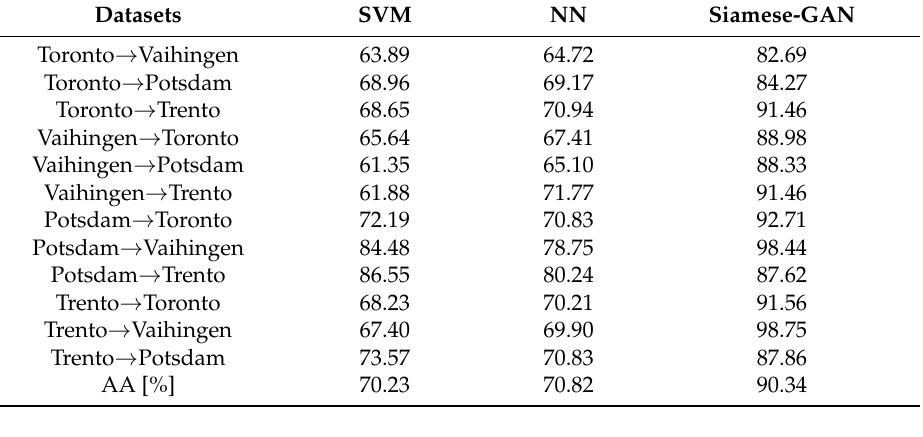
Figure 7. The adversarial losses of Siamese-GAN for the scenarios: ( a ) Potsdam → Vaihingen, ( b ) Trento → Toronto, and ( c ) Toronto → Vaihingen. Table 2. Results are expressed in terms of OA [%] and AA [%] over the 12 scenarios.